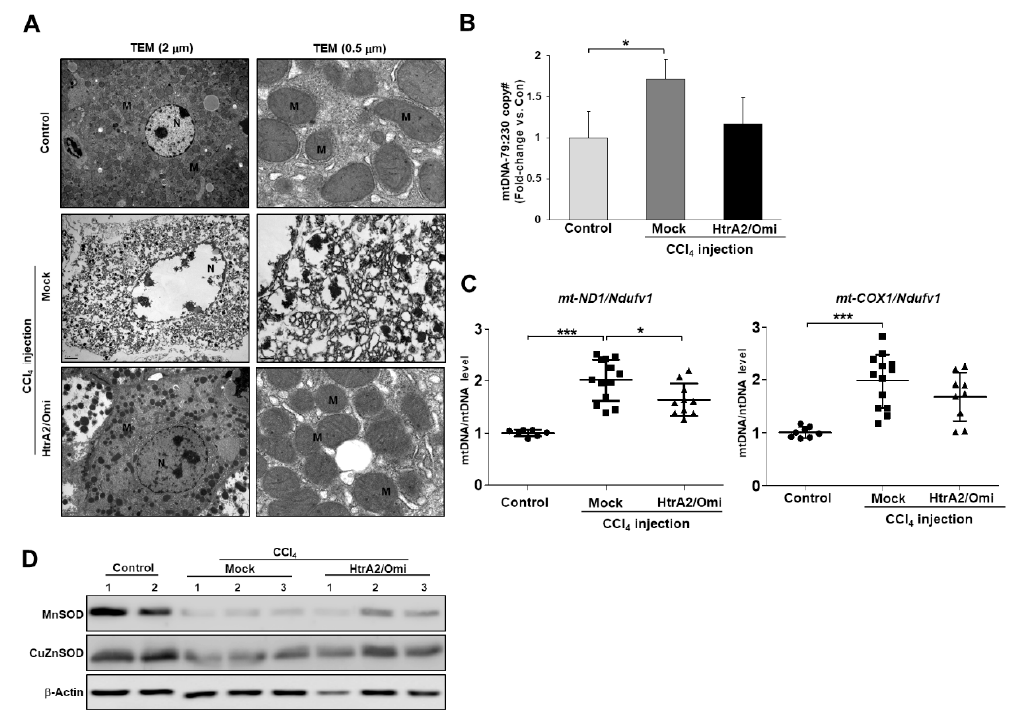
Figure 7. HtrA2 / Omi expression in CCl 4 -induced liver fibrosis protects mitochondrial damage of hepatocyte. ( A ) TEM analysis of hepatocyte showing nucleus (N) and mitochondria (M) (scale bar = 2 & 0.5 µ m). ( B ) Damaged mtDNA levels of the 79 bp fragment (damaged) and 230 bp fragment (undamaged) in gDNA isolated from liver tissue were assessed by qPCR. Bars represent mean copy number ratios of mtDNA-79:230, normalized to 18S levels. ( C ) qPCR analysis of mt-ND1 and mt-COX1 DNA normalized to nuclear Ndufv1 DNA. ( D ) Western blot analysis of MnSOD and CuZnSOD expression in liver tissue from pFLAG-HtrA2 / Omi treated fibrotic mice compared to mock vector treated fibrotic mice.